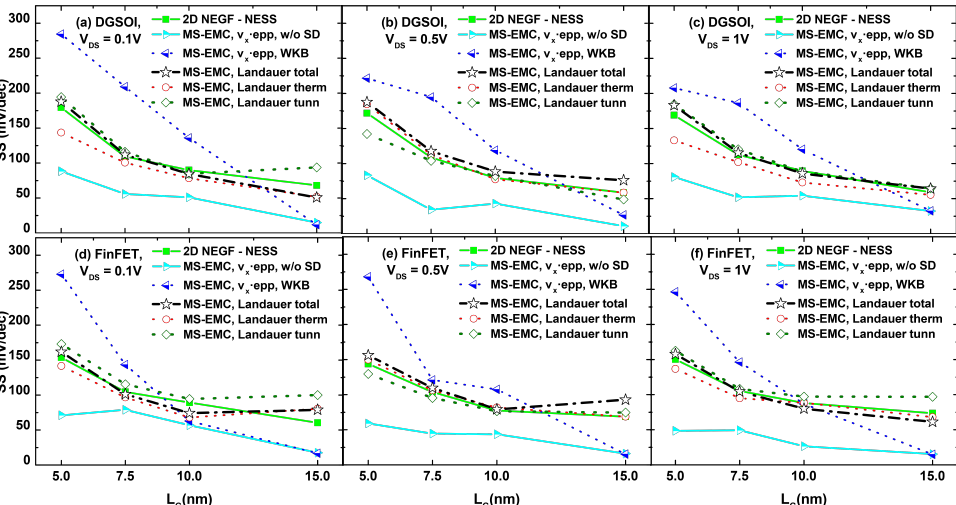
Figure 11. Subthreshold swing values (SS) as a function of the gate length for the DGSOI and FinFET considering different drain voltages: ( a ) DGSOI with V DS = 0.1 V, ( b ) DGSOI with V DS = 0.5 V, ( c ) DGSOI with V DS = 1 V, ( d ) FinFET with V DS = 0.1 V, ( e ) FinFET with V DS = 0.5 V, and ( f ) FinFET with V DS = 1 V. Current computation corresponds to the different techniques analyzed in our work: NEGF, MS-EMC with the standard approach (with and without S/D tunneling), and MS-EMC incorporating